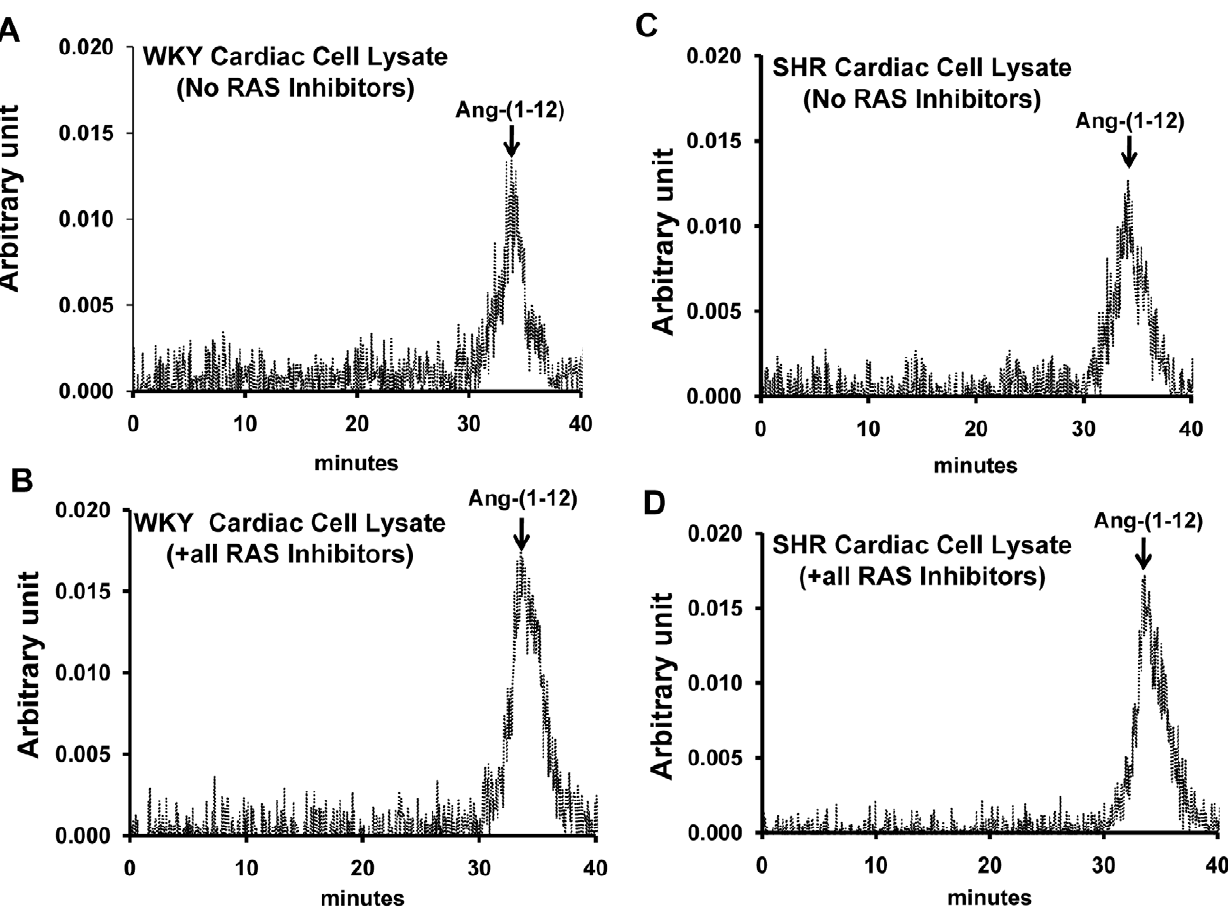
Figure 2. Effect of inhibitors on Ang-(1–12) metabolism in cardiac myocytes. Characterization by high pressure liquid chromatography of cellular 125 I-Ang-(1–12) products internalized by 24-h serum deprived cultured neonatal WKY (A and B) and SHR (C and D) cardiac myocytes in the presence of all inhibitors cocktail (containing lisinopril, SCH39370, MLN-4760, chymostatin, amastatin, bestatin, benzyl succinate and PCMB) and in the absence of RAS inhibitors (containing only amastatin, bestatin, benzyl succinate & PCMB) each added at a dose of 10 m M. Before adding the 125 I-Ang-(1–12), the cultured cardiac myocytes were pre-incubated with inhibitors for 15 min at 37 u C. The arrow indicates the peak area of 125 I-Ang-(1–12).